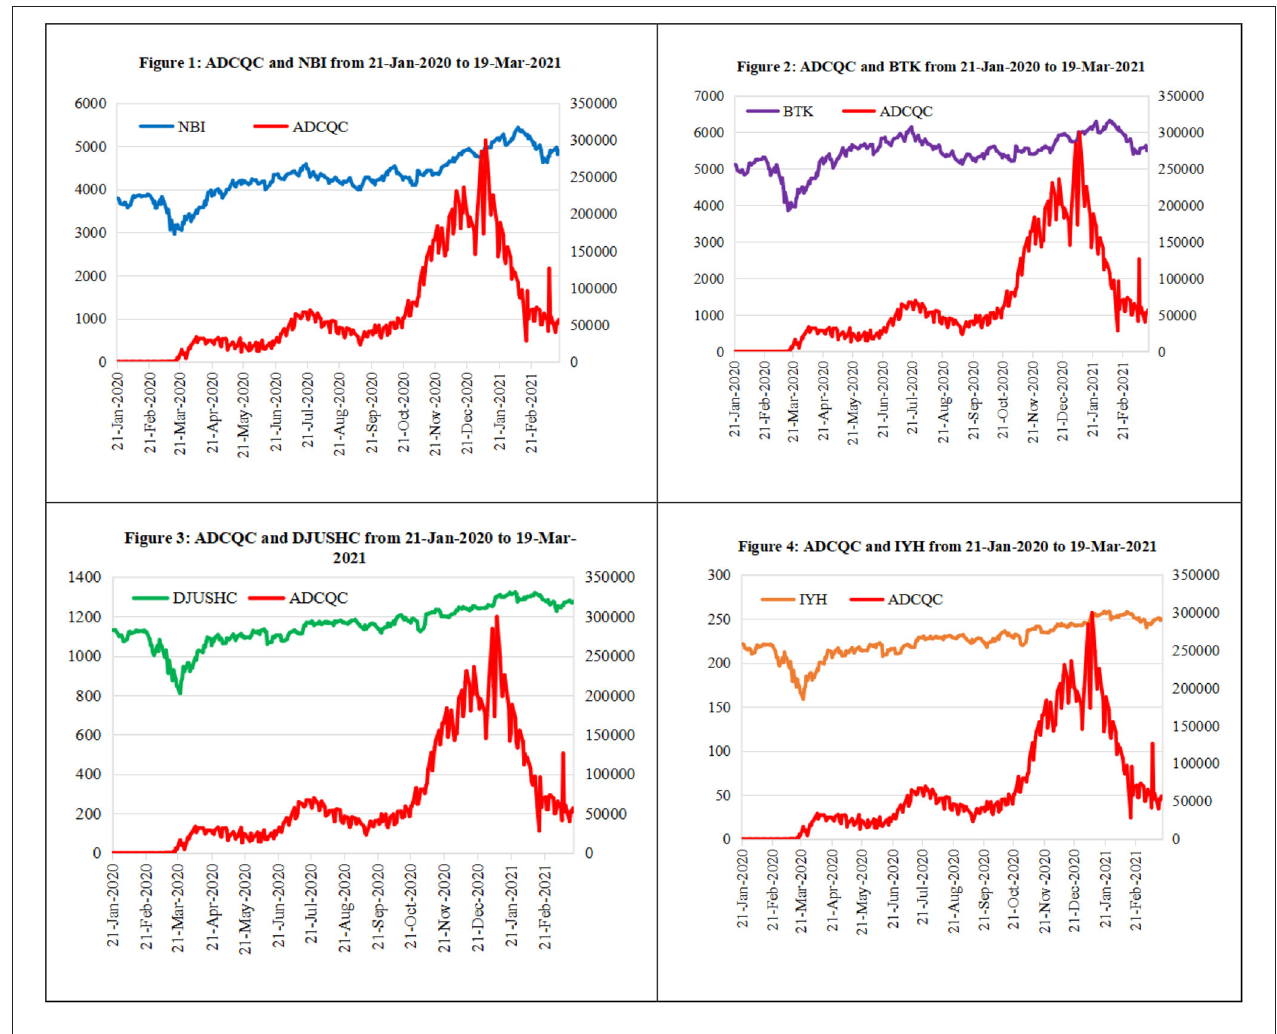
FIGURE 2 | The trendlines of ADCQC, NBI, BTK, DJUSHC, and